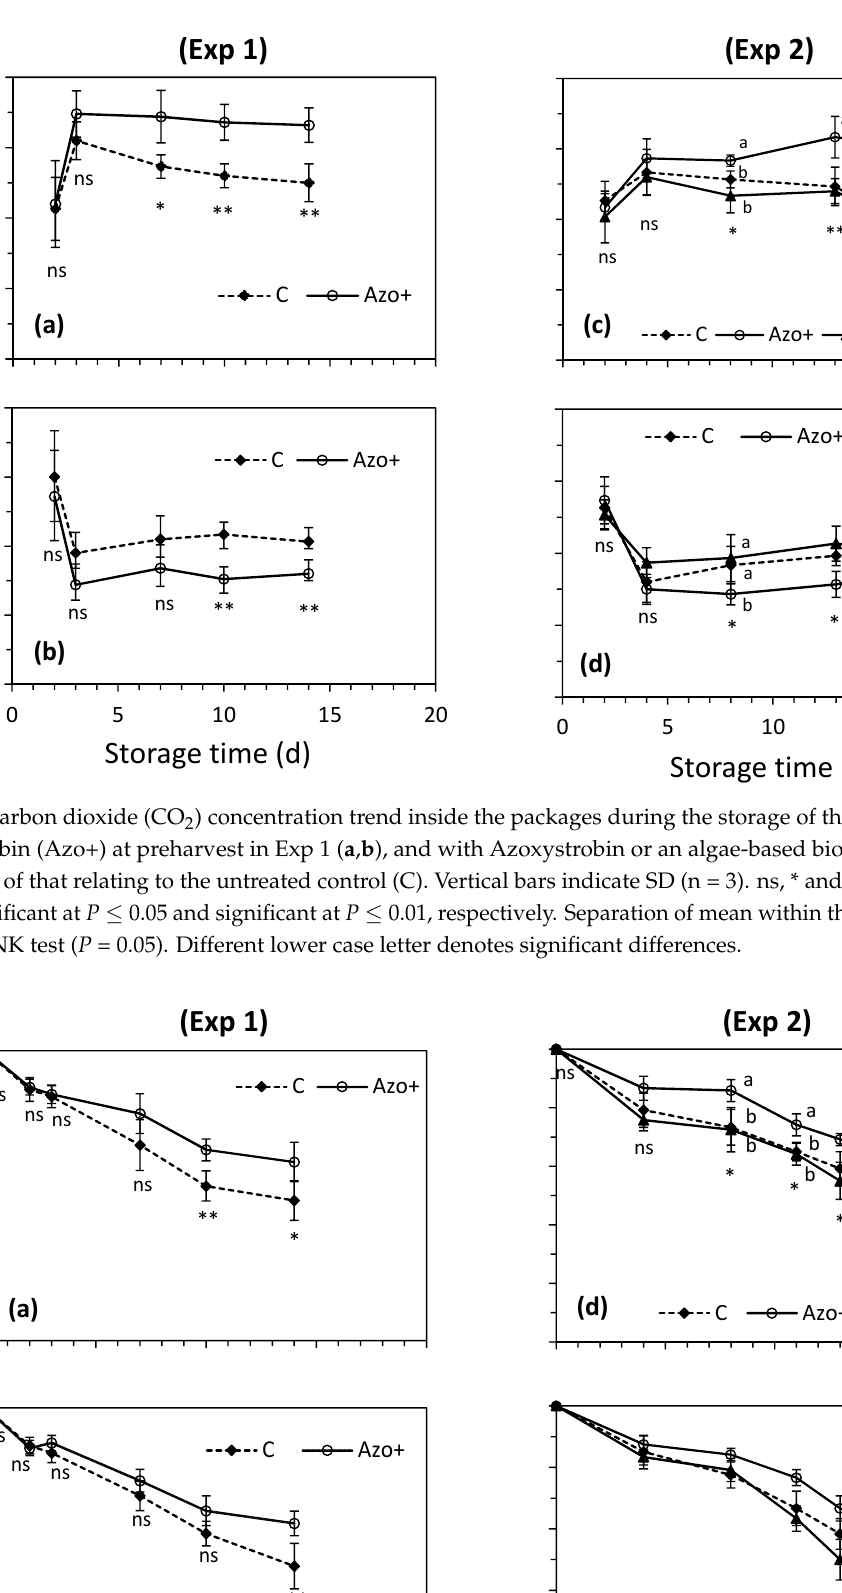
Figure 2. Trend of the visual appearance, odor and yellow index during the storage of the wild rocket treated with Azoxystrobin (Azo +) at preharvest in Exp 1 ( a – c ), and with Azoxystrobin or an algae-based biostimulant (YBA+) in Exp 2 ( d – f ), and of that relating to the untreated control (C). Vertical bars indicate SD (n =3). ns, * and ** indicate F test not significant, significant at P ≤ 0.05 and significant at P ≤ 0.01, respectively. Separation of mean within the days from the start of storage by SNK test ( P = 0.05). Different lower case letter denotes significant differences. The nonmarketable values of these two indicators are reached 10 days after storage (DAS) in C and 12 DAS in Azo+. The YI also increased more rapidly in the control (Figure 2c). This parameter, in fact, from the beginning of storage to the end, was reduced by 11.0 and 24.1%, respectively for Azo+ and C. TC decreased during storage by 19.1 and 23.3%, respectively for Azo+ and C (Figure 3b).